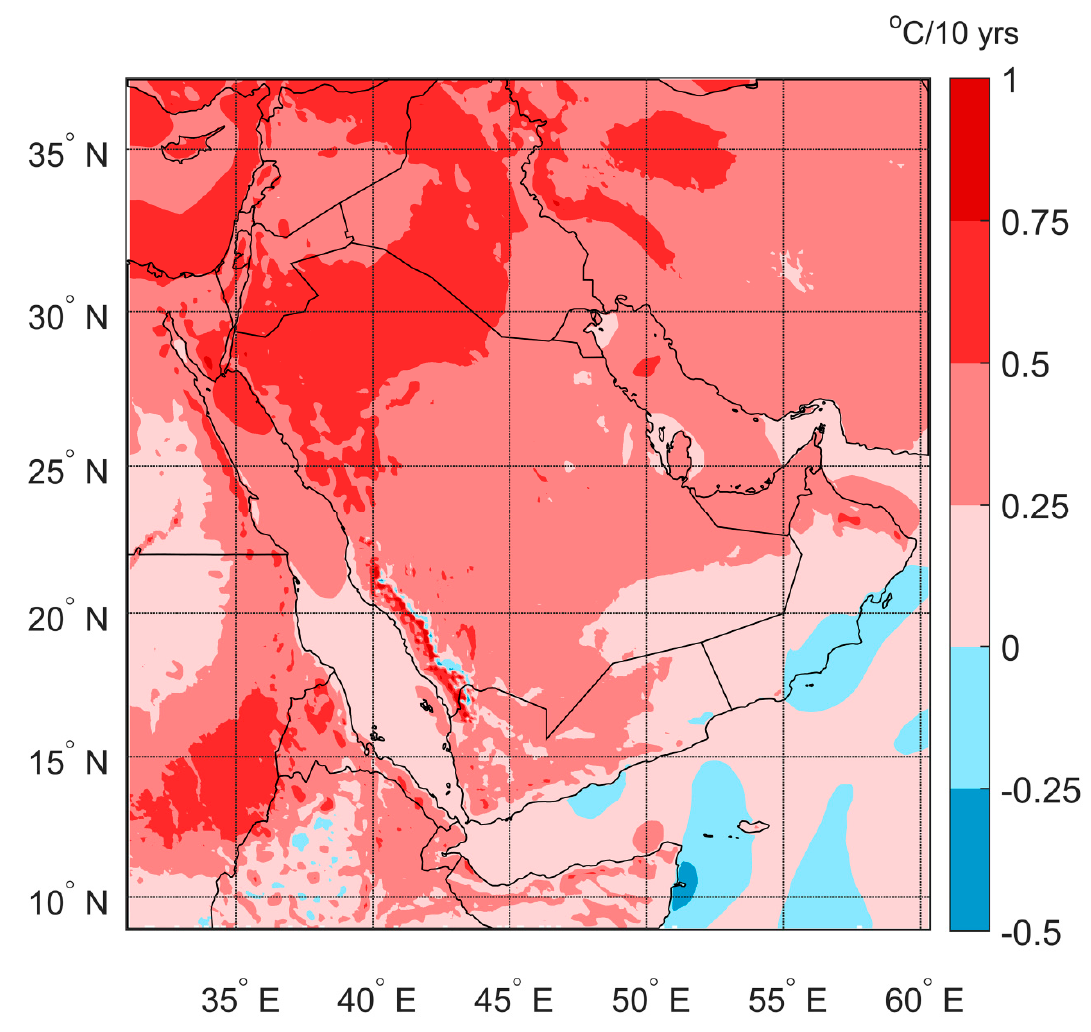
Figure 15. Mean temperature change per 10 years (yrs).